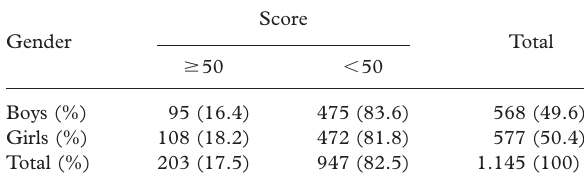
Table I. Gender distribution of the questionnaires’ scores. Gender